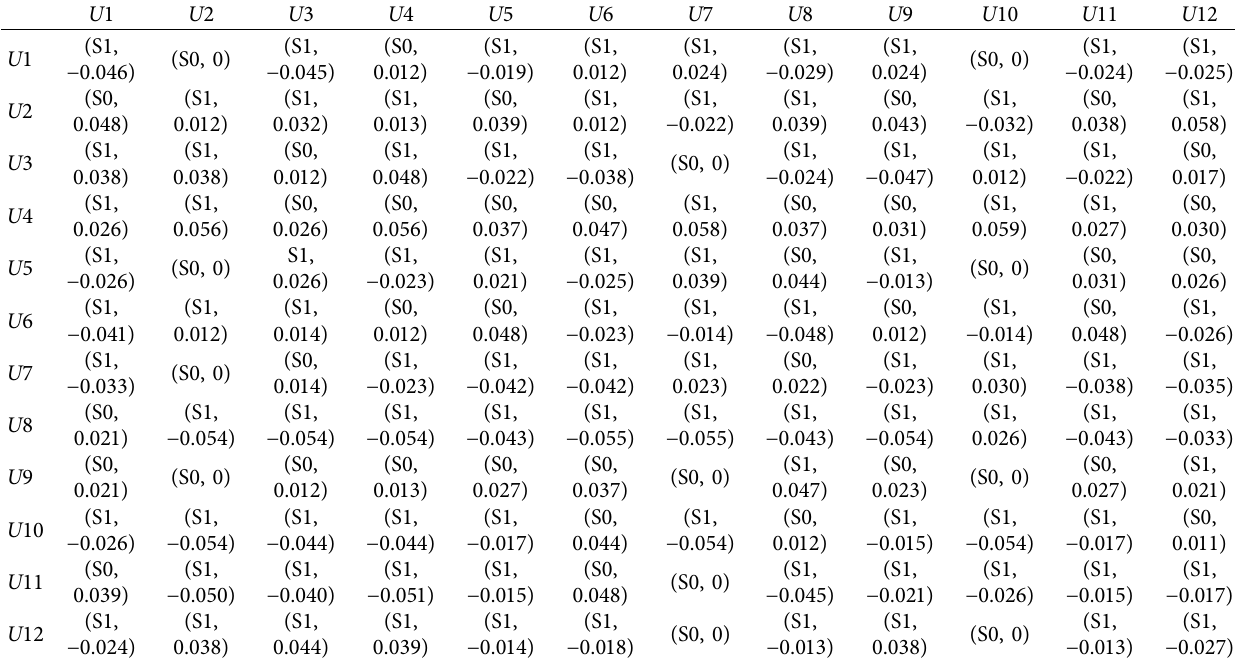
Figure 7: Network relationship diagram of metro deep foundation pit risk Table 11: Weight matrix.